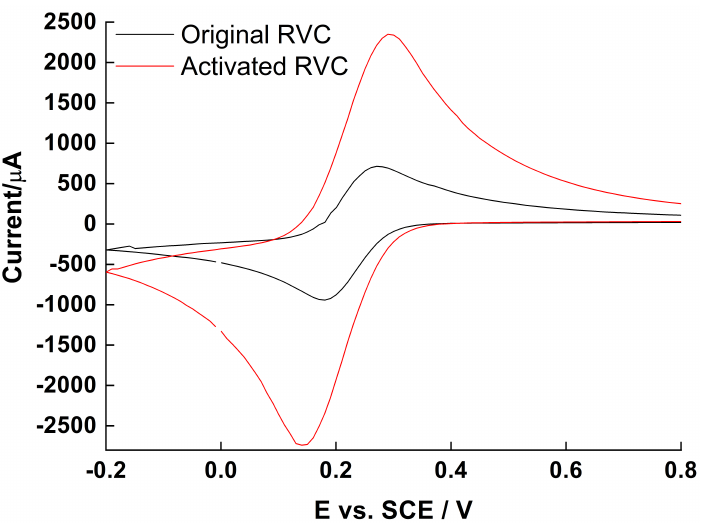
Figure 1. Cyclic voltammetry (CV) of 1.25 mM K 3 Fe(CN) 6 in 1 M KNO 3 on original and activated RVC electrode respectively, scan rate 10 mV s − 1 .